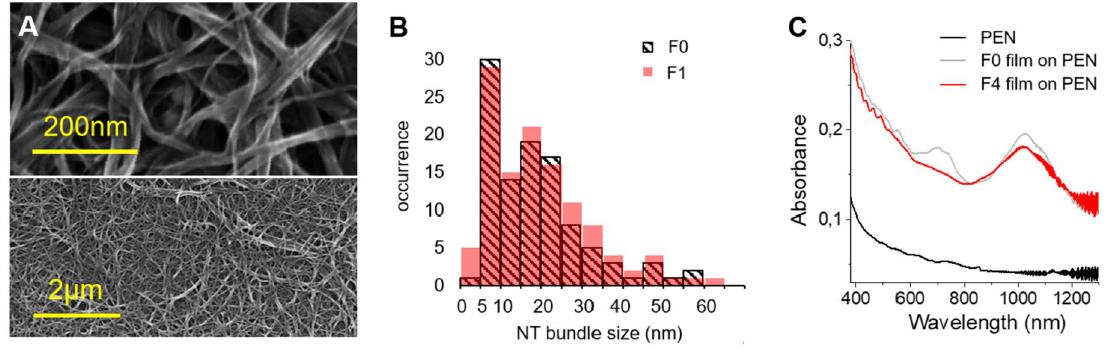
Fig. 2 SWCNT films by spray. A: Scanning electron microscopy (SEM) images of SWCNT films prepared by spray on PEN. B: size histogram of SWCNT bundles in the film from SEM images. C: Absorption spectra of SWCNT